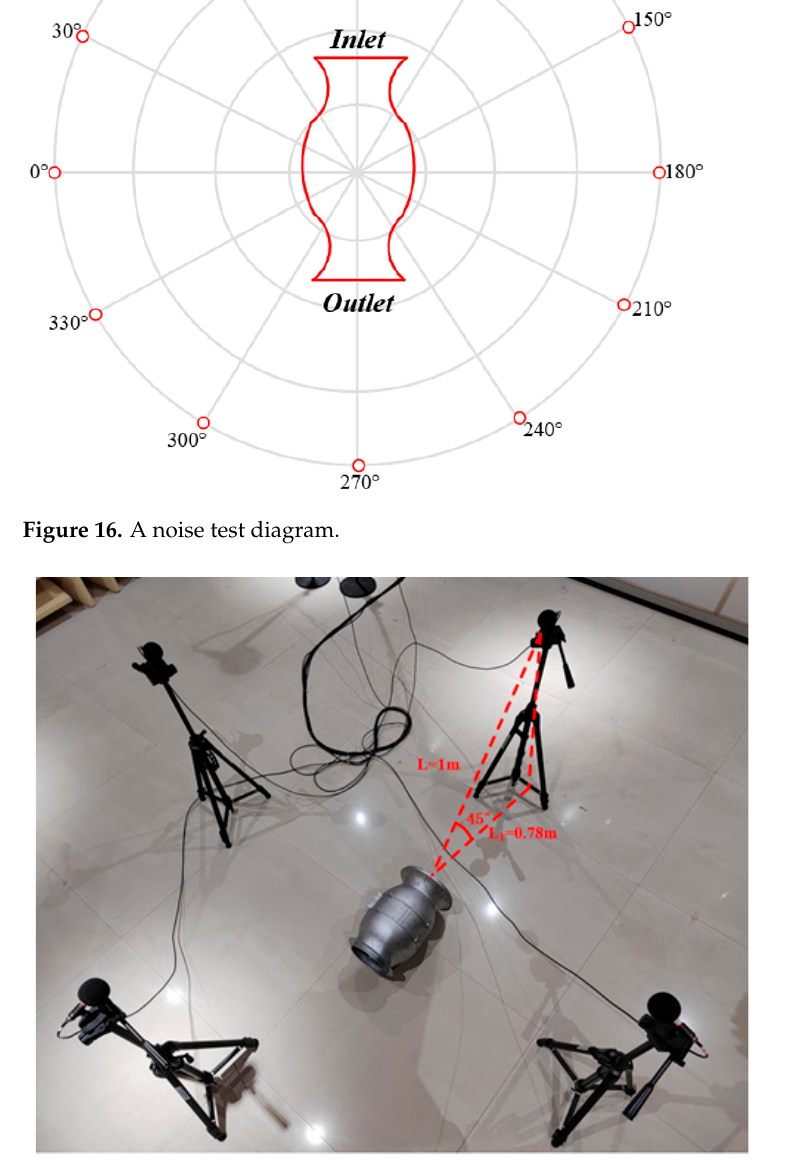
Figure 17. The noise performance testing.